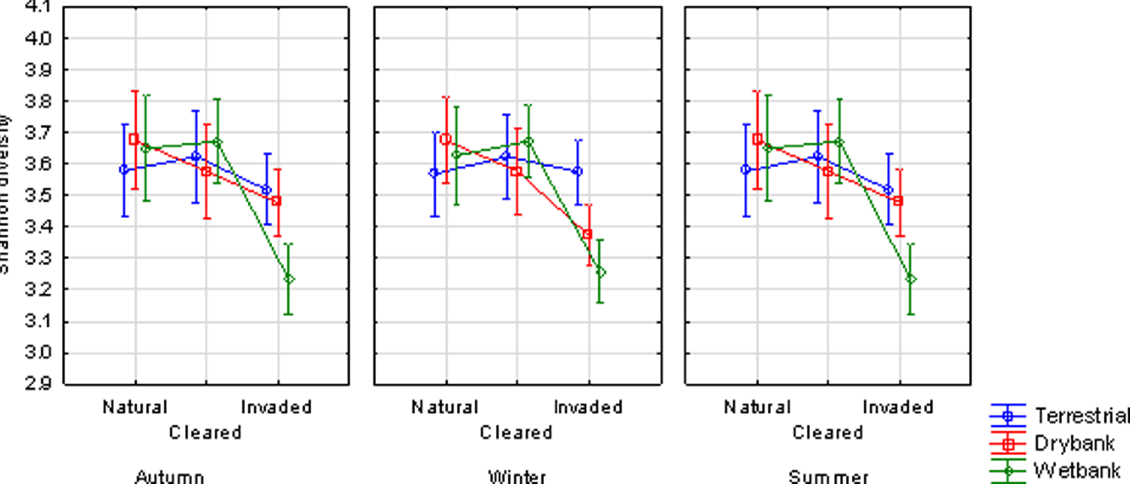
Figure 3. The Shannon’s diversity index based on the bacterial ARISA profiles comparing natural, cleared and invaded lateral zones for all three seasons. The interaction effect between hydrological zones and the invasive status was significant (F=2.7191, p=.00580).